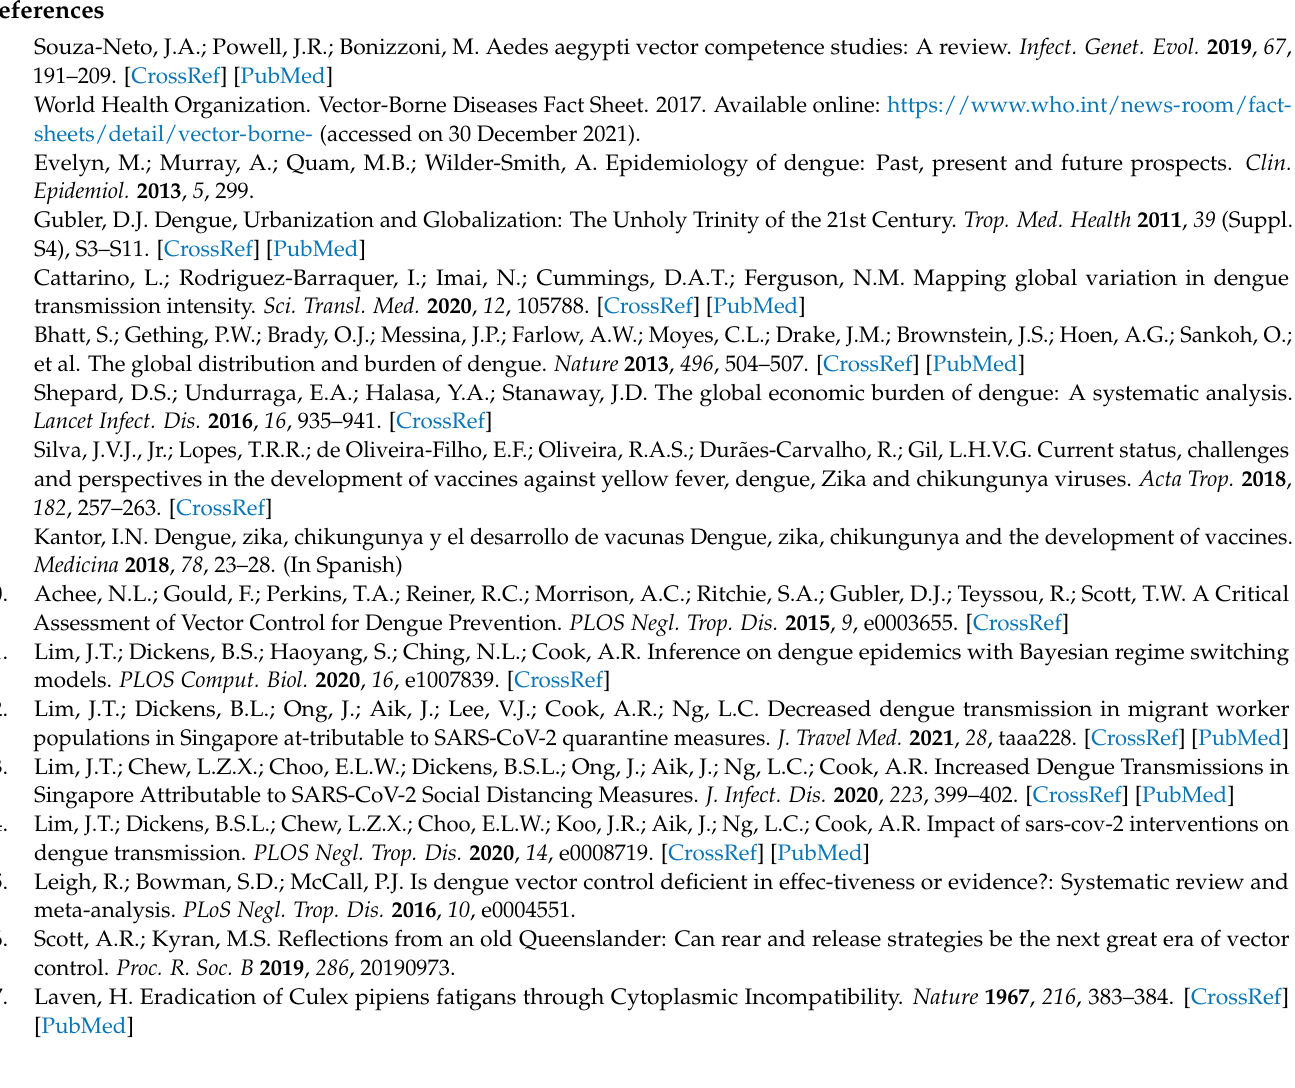
Table S2: Different intervention start/endpoints used for simulation; Figure S1: Alternative scenario wildtype female mosquito population; Figure S2: Alternative scenario w Alb female population; Figure S3: Alternative scenario w Mel female mosquito population. Reference [53] was cited in the Supplementary